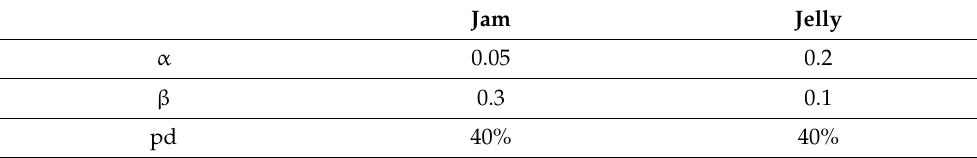
Table 2. Statistical